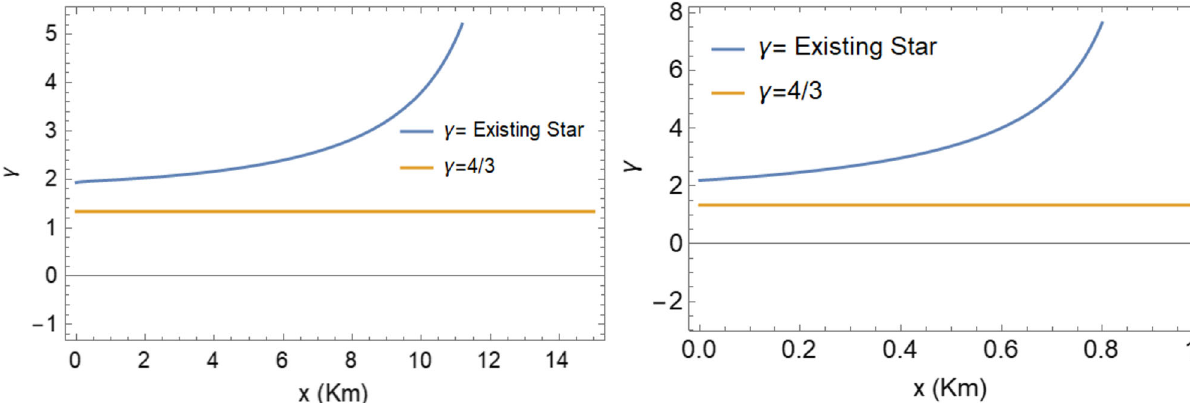
Fig. 7 Variation of adiabatic index with radius